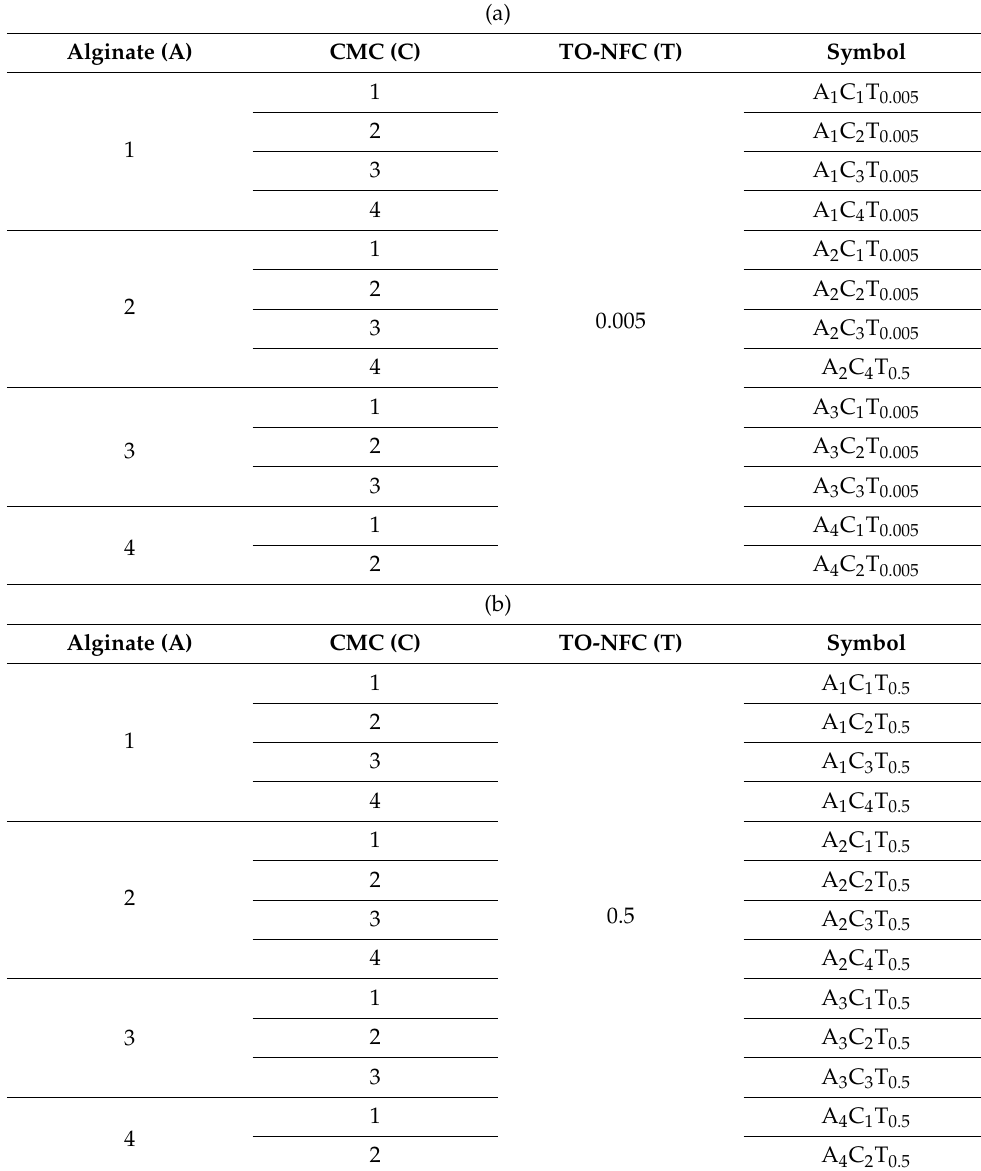
Table 1. Various compositions prepared with different weight percentages of alginate (1, 2, 3, and 4%, w / v ), CMC (1, 2, 3, and 4%, w / v ), and TO-NFC (0.005% and 0.5%, w / v